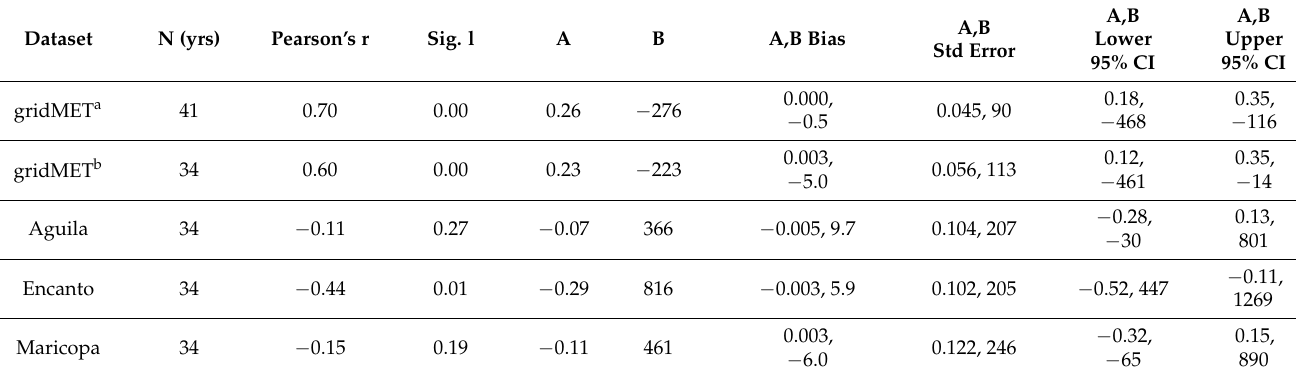
Table 8. Linear regression K ↓ ANNUAL = A*(year) + B with bootstrapping (N=1000). Time series defined in Table 7.